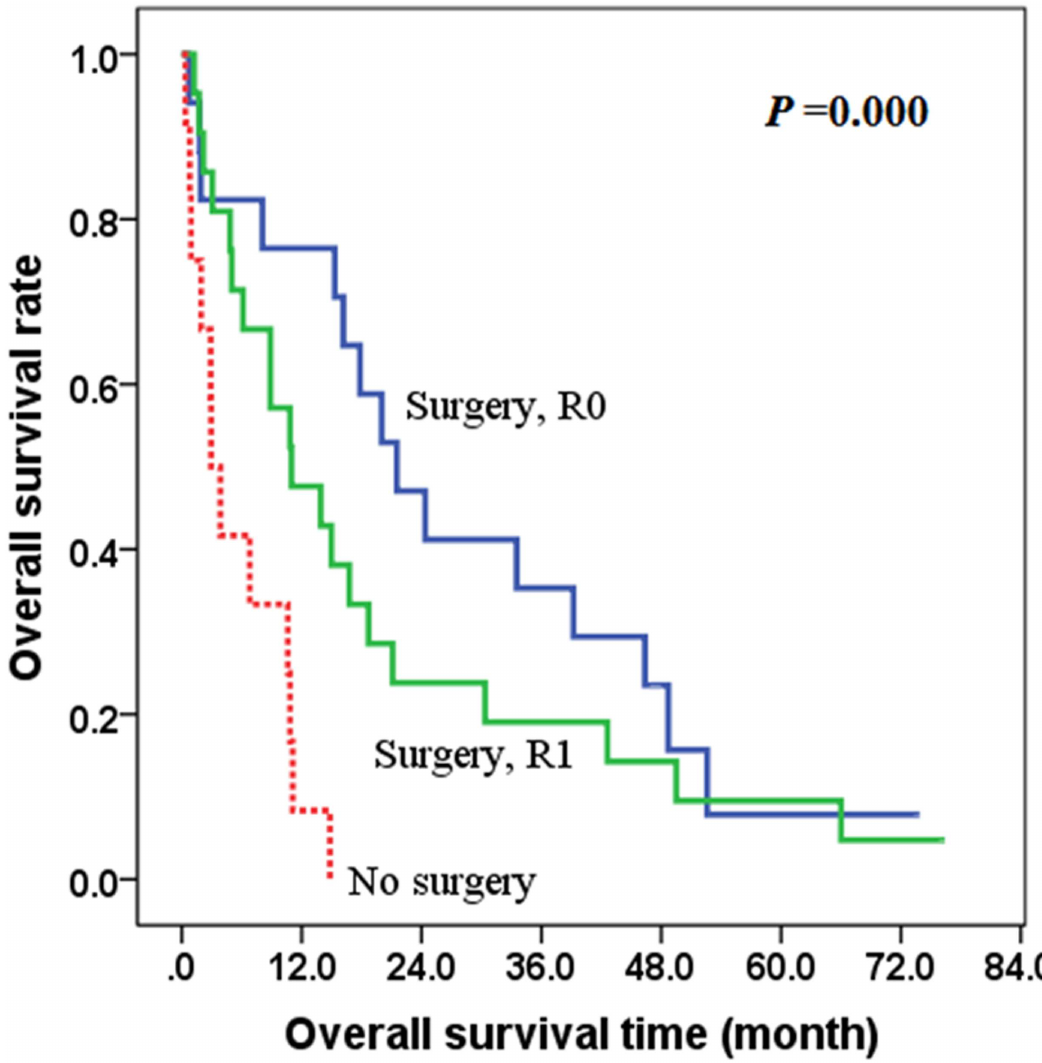
Fig 3. The effect of radical surgery on overall survival of ATC